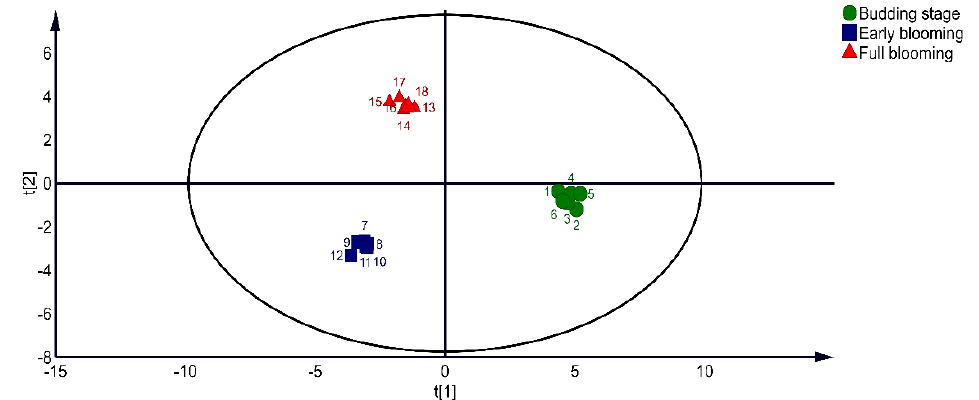
Figure 2. OPLS−DA 2D scores of alfalfa at different harvest periods.